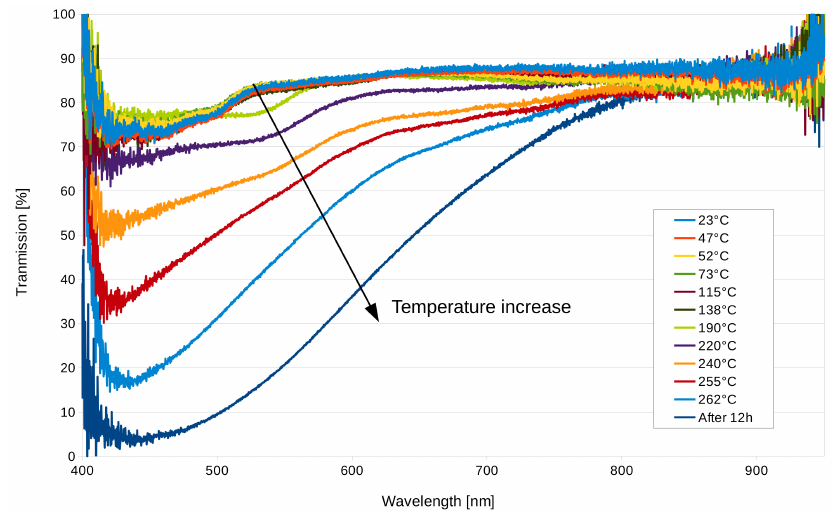
Figure 4. Transmission spectrum of the Bayfol ® HX200 sample without hologram, depending on temperature.